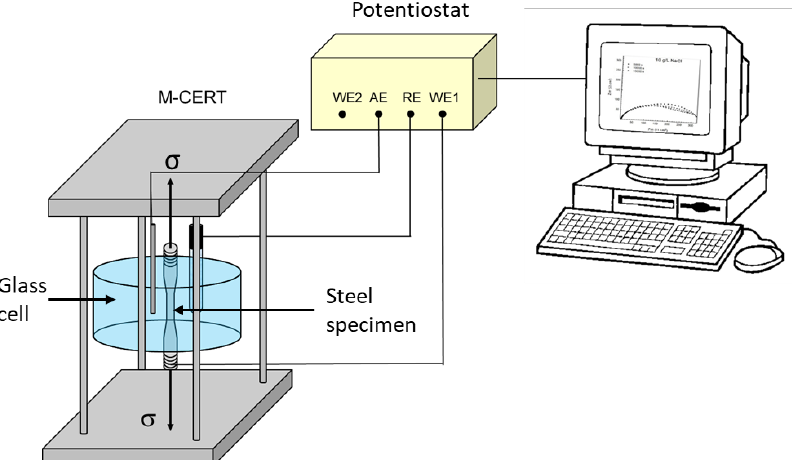
Figure 1. Schematic representation of SSRT setup and electrochemical cell for impedance measure-